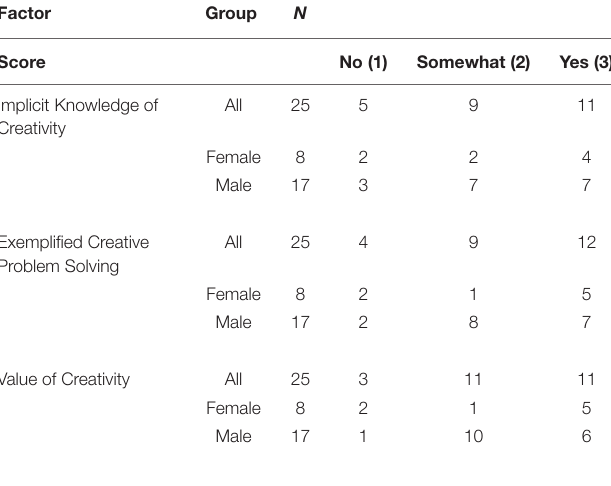
TABLE 5 | Counts for creativity factors.